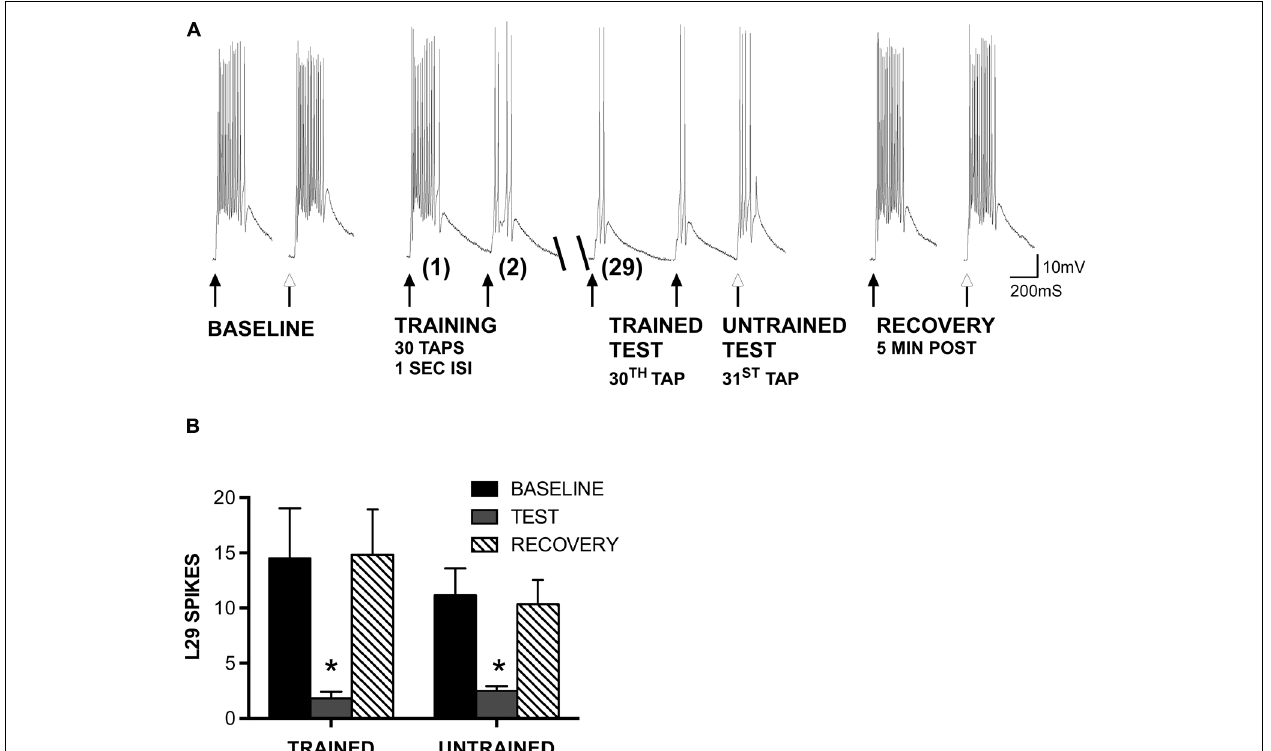
and untrained sites exhibited reduced responses with training compared to baseline. Responses at both sites recovered 5 min later. (B) Quantitative data from six experiments. Both the trained and untrained sites exhibited a significant decrease from baseline (* p < 0.05 from baseline using Bonferroni post